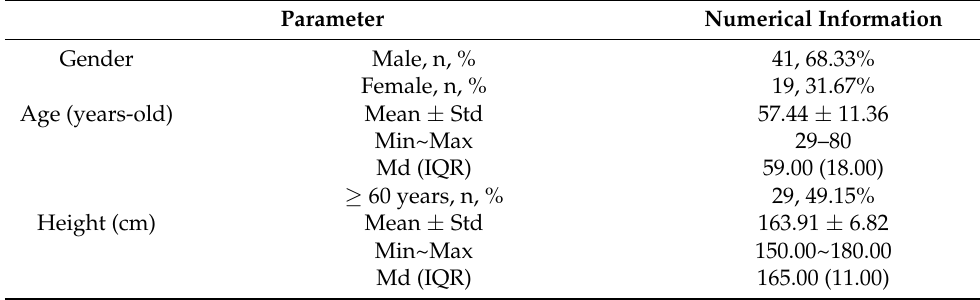
Table 1. Basic characteristics of